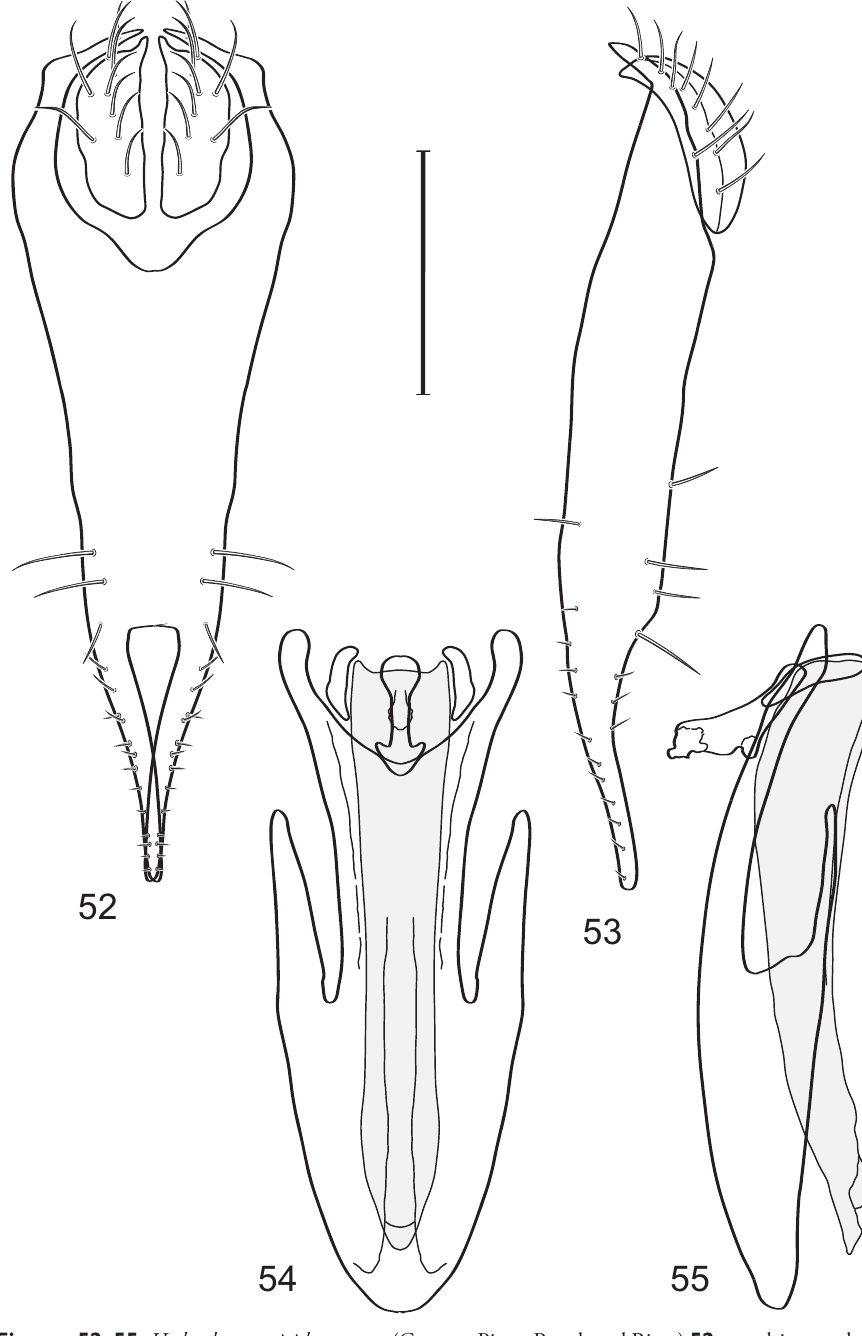
Figures 52–55. Hydrochasma viridum sp. n. (Guyana. Pirara Ranch and River) 52 epandrium and cerci, posterior view 53 same, lateral view 54 internal structures of male terminalia (aedeagus [shaded], phal- lapodeme, gonite, hypandrium), ventral view 55 same, lateral view. Scale bar = 0.1